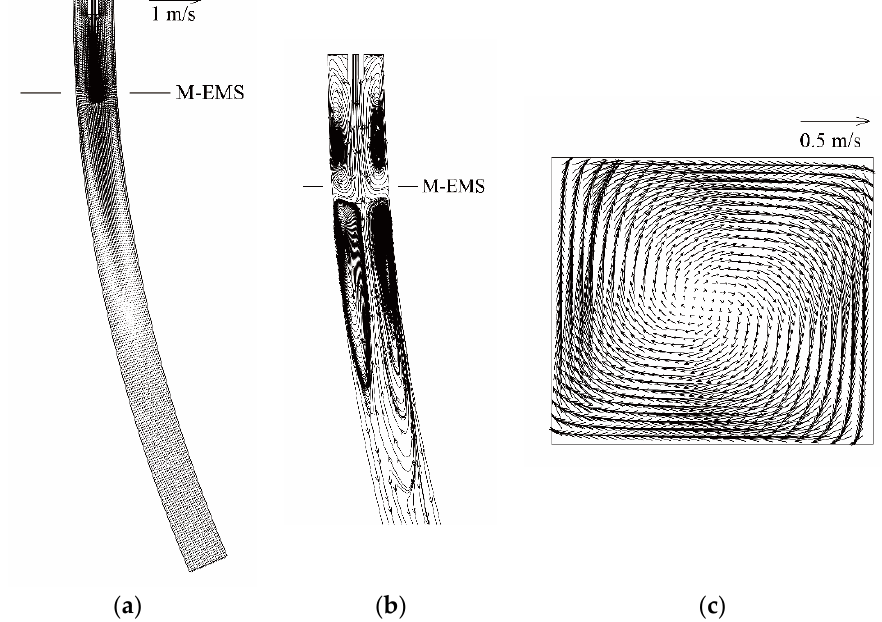
Figure 7. Liquid steel flow in curved bloom continuous caster with M-EMS: ( a ) vertical longitudinal- section; ( b ) stream line (enlarged part); ( c ) M-EMS central cross-section.